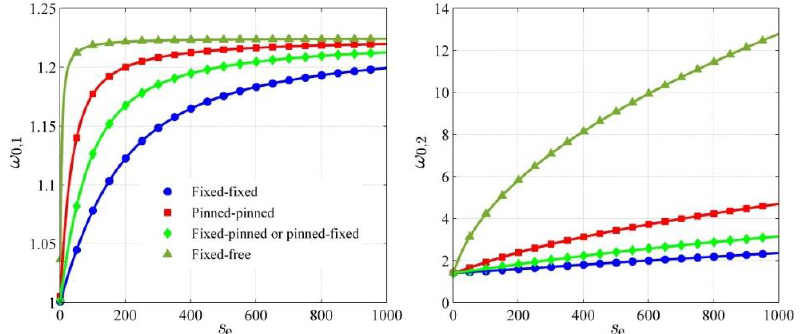
Figure 5. Frequency ratios in two sub-modes corresponding to the 1st basic mode versus contact stiffness ratio ( 𝑠 e ) for different boundary conditions when 𝑠 m = 1 and 𝑠 k = 2 .